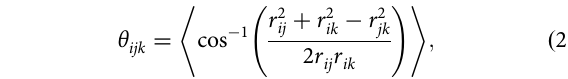
where i , j , k are the central atom and two arbitrary atoms indices, types 7